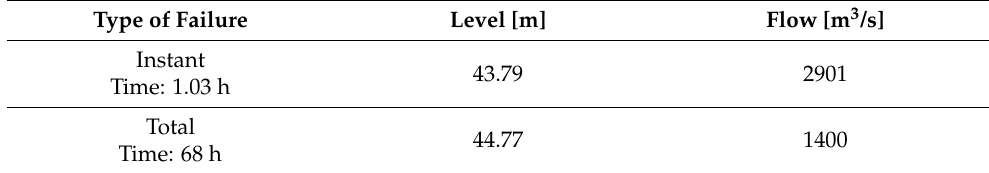
Table 9. Maximum levels and flows for the different scenarios of dam failure.